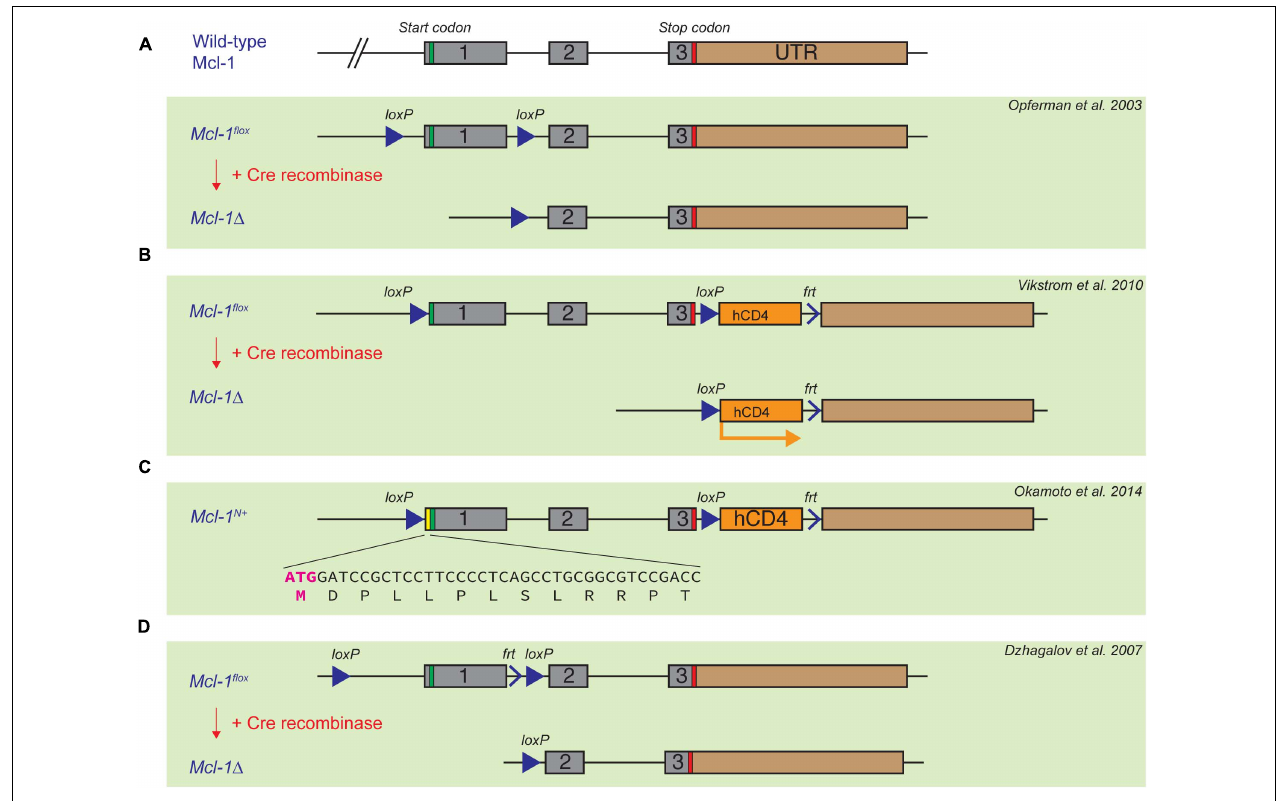
FIGURE 2 | Established floxed Mcl-1 mouse model systems. (A) Opferman et al. introduced two LoxP sites to the Mcl-1 locus upstream of the ATG start codon, and between exon 1 and exon 2, respectively. (B,C) In the second floxed Mcl-1 model, Bouillet et al. introduced two LoxP sites upstream of the ATG start codon of the Mcl-1 gene, and between exon 3 and 4, respectively. A truncated and non-functional form of hCD4 is introduced downstream of exon 4, which can be subsequently expressed under the control of the endogenous Mcl-1 promoter upon Cre-induced recombination (B) . A serendipitous introduction of 13 extra amino acid in the 5’UTR region of the Mcl-1 locus resulted in a more stable form of Mcl-1 protein (C) . (D) Dzhagalov et al. introduced LoxP sites flanking exon 1, but the first LoxP site is much further upstream of exon 1 in comparison with the other two floxed Mcl-1